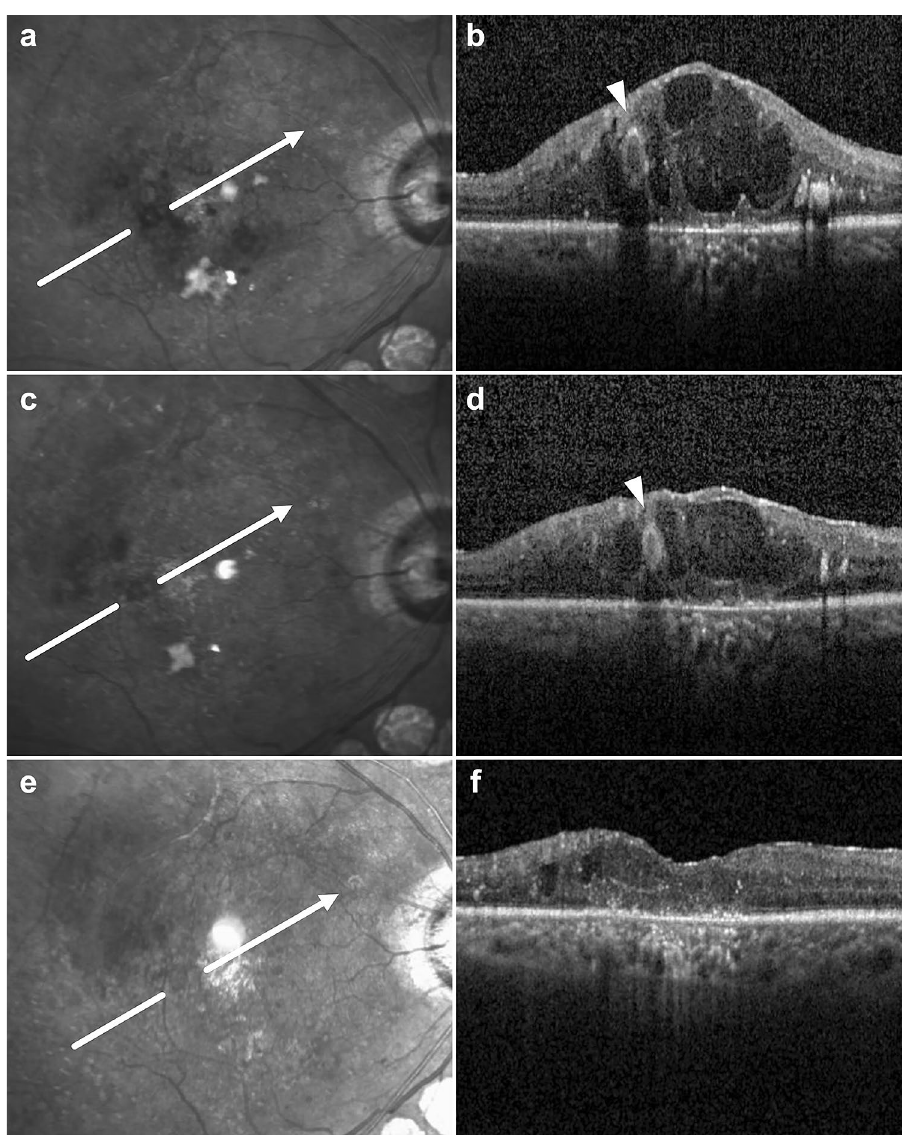
Figure 2. Infrared (IR) reflectance and spectral-domain optical coherence tomography (OCT) images of the telangiectatic capillary (TelCap) (arrowhead) before ( a , b ) and after ( c – f ) focal laser photocoagulation in persistent diabetic macular edema. ( c , d ) Three months after focal laser photocoagulation of the TelCap, the TelCap size decreased on both the IR image and OCT, and the macula edema improved. ( e , f ) One year following laser treatment, the TelCap lesion disappeared, and the macula edema and lipid exudates around the TelCap were resolved markedly. The findings outlined above showed the relationships between TelCap lesion and these macular